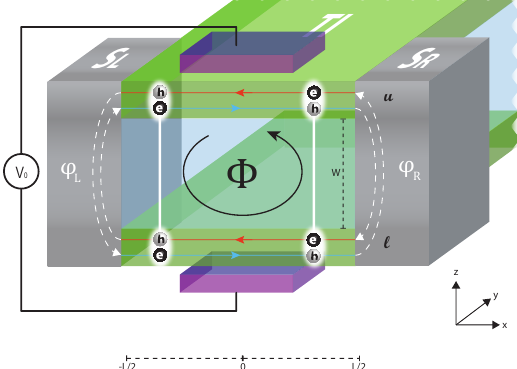
Figure 1. Schematic representation of the setup: it consists of an heterostructure (say CdTe-HgTe) grown along the z -axis resulting in two layers of TIs. In gray are depicted the superconductors ( S L / R ) while in green the TI planes. The arrowed blue (red) solid lines represent the 1D helical edge states with spin ↑ ( ↓ ). On the frontal side, in the x - z -plane of the scheme, are depicted two CAR processes where CP are non-locally splitted. The application of the Rashba and Zeeman-like fields due to the presence of side gates and the induced magnetic flux Φ . Such a fields act in terms of the unitary operators U u ( θ ) (see text) on the upper and lower edges and U (cid:96) SO SO